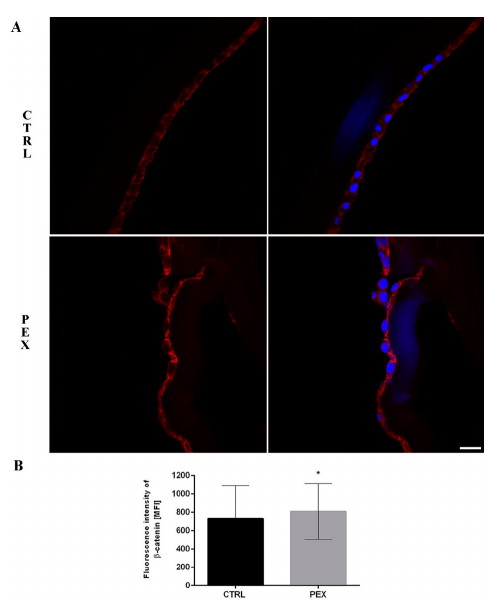
Figure 2. The fluorescence staining of β -catenin. The increased concentration of β -catenin in the area between lens epithelial cells in the PEX group vs. the control group ( A ). A significant increase in the level of expression of β -catenin in lens epithelial cells of the PEX group, compared to the control group. Data shown represent the mean ± SD obtained from PEX n = 29 and CTRL n = 23. The statistically significant results were marked by an asterisk ( * p < 0.05; Mann-Whitney U test) ( B ).